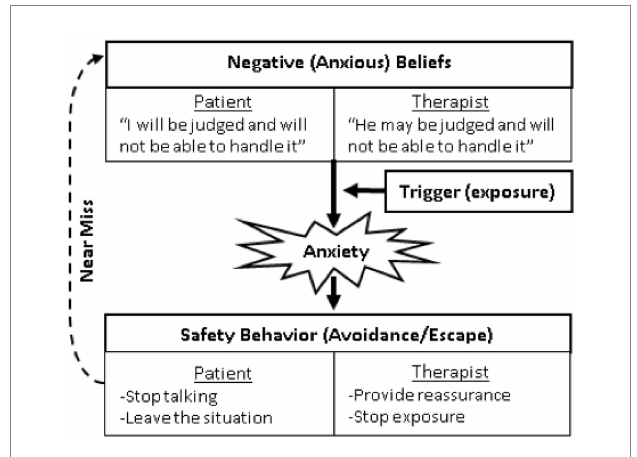
FIGURE 1 CBT model of patient and therapist